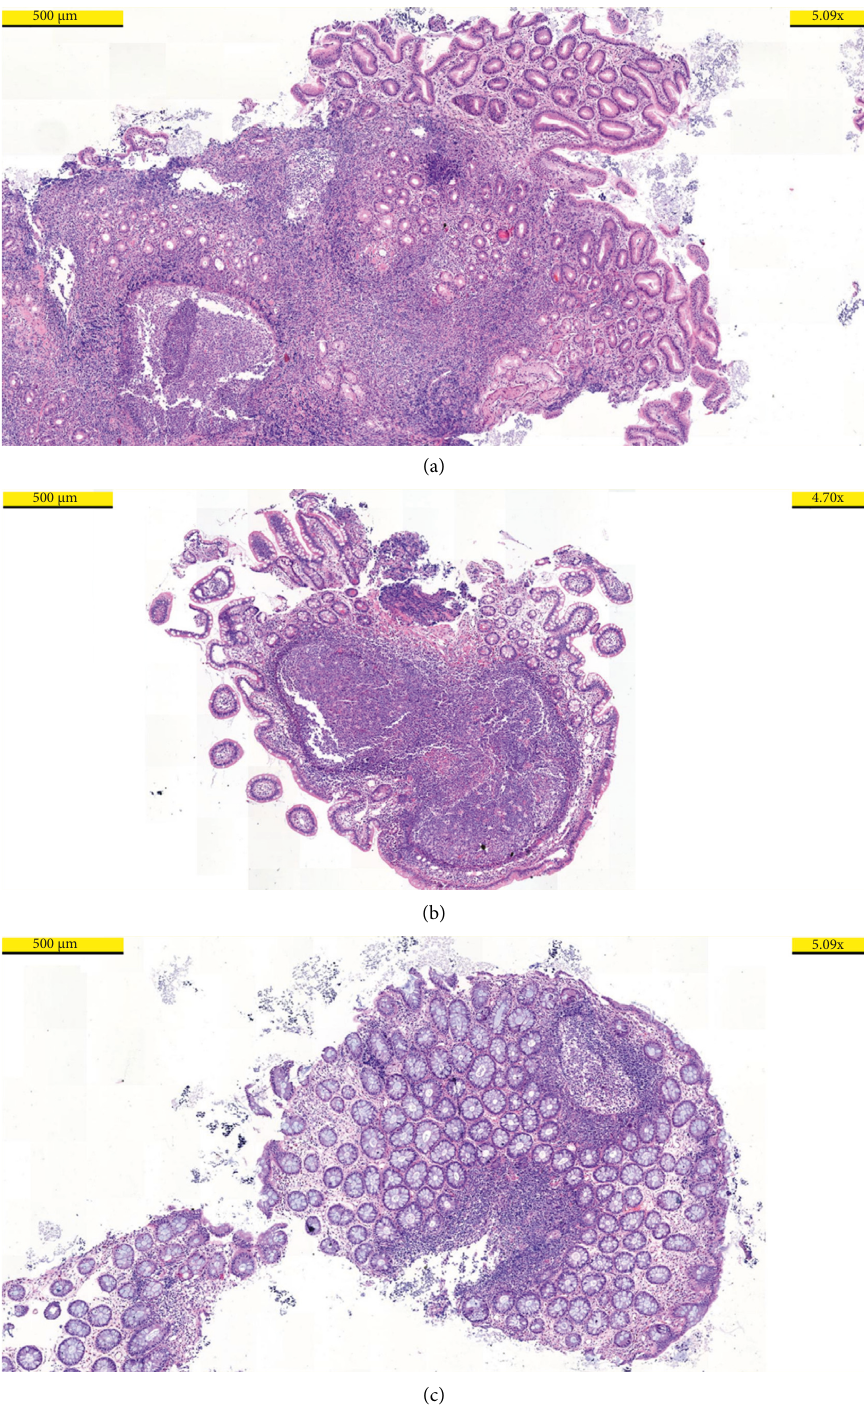
Figure 2: Hyperplastic lymphoid follicles with prominent germinal centers, in keeping with nodular lymphoid hyperplasia. Stomach (a), small intestine (b), and colon (c) biopsies with haematoxylin-eosin